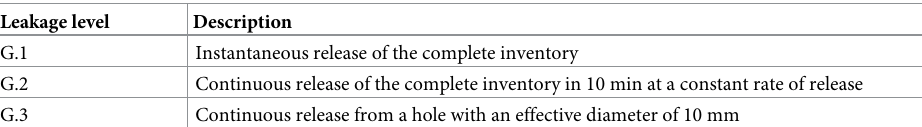
Table 1. LOCs for stationary